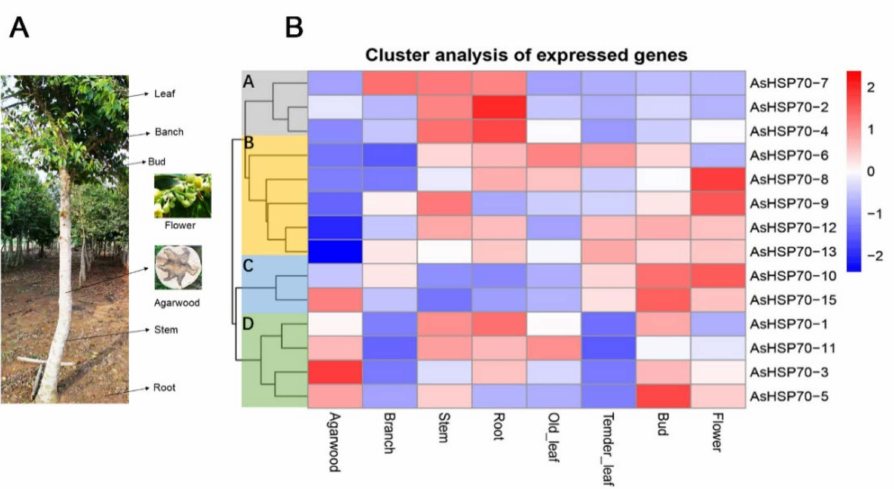
Figure 7. Heat map of the AsHSP70 genes expression profile in different tissues and different tissues of A. sinensis trees. ( A ). The different tissues of A. sinensis trees. The agarwood layer was obtained after trees was wounded by external stimulus. ( B ). All gene expression levels were transformed to scores ranging from − 2 to 2 and were colored blue, white, or red to represent low, moderate, or high expression levels,